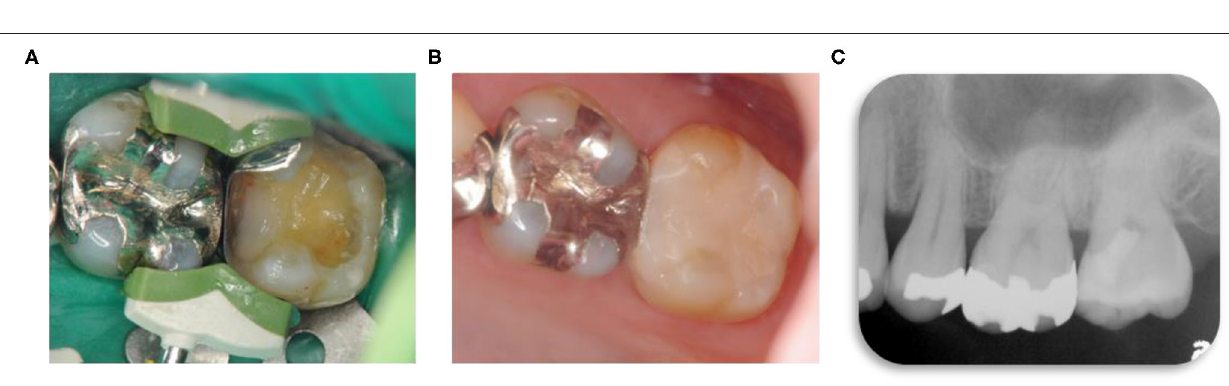
FIGURE 4 | Images at follow-up visit 8 months after completion of the partial pulpotomy. (A) Composite 3D system for resin-based composite. (B) Intraoral image 12 months after the partial pulpotomy. (C) Radiographic image 12 months after the partial pulpotomy revealed the absence of an apical radiolucency indicative of apical